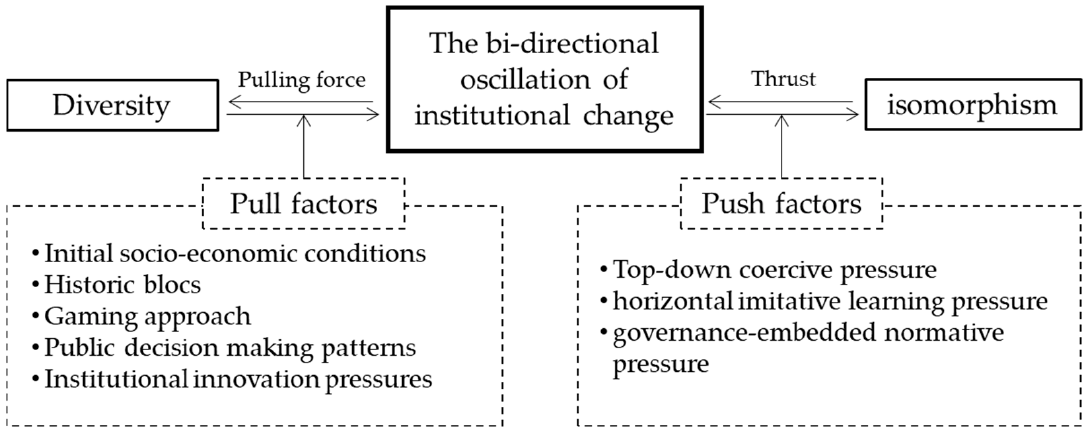
Figure 7. Schematic diagram of the bi-directional oscillation of institutional